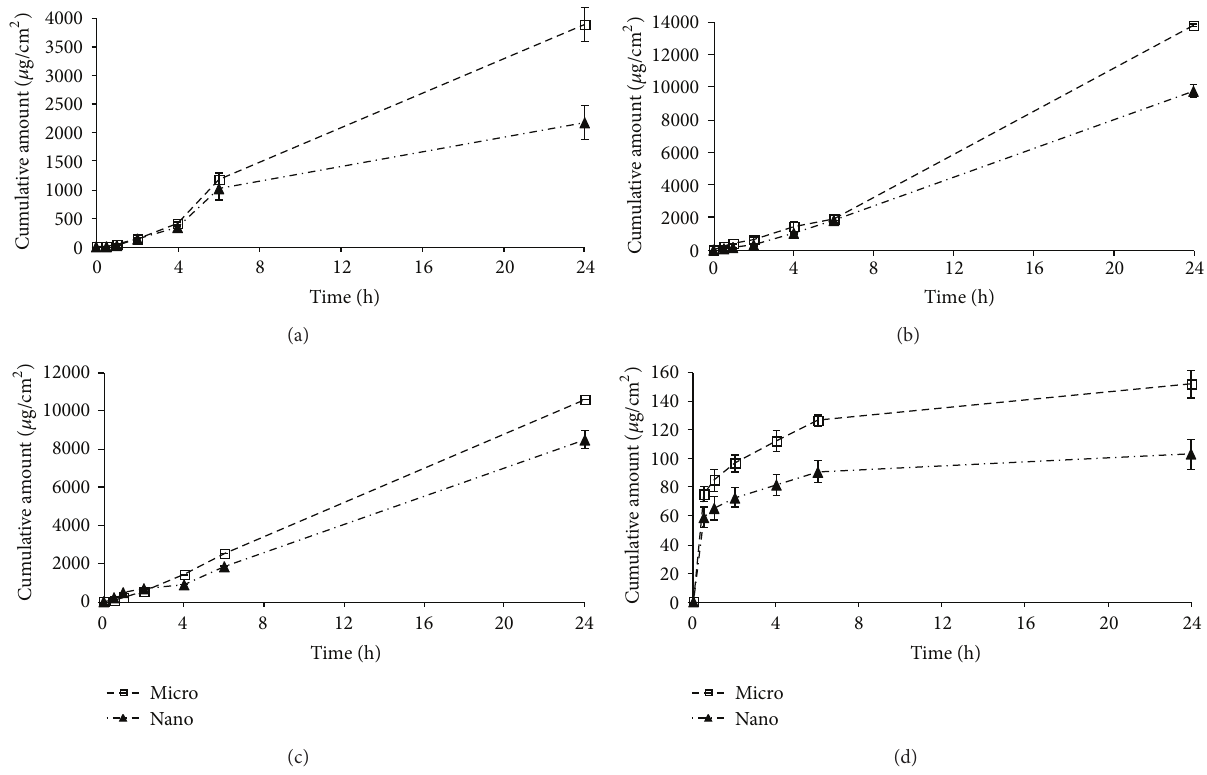
Figure 2: In vitro penetration-time profile of micronized/nanonized alaptide through skin from buffer (a) and from the following pharmaceutical compositions: gel (b), cream (c), and ointment (d). Points with error bars represent mean values of cumulative permeations (mean ± SD) determined in five experiments.